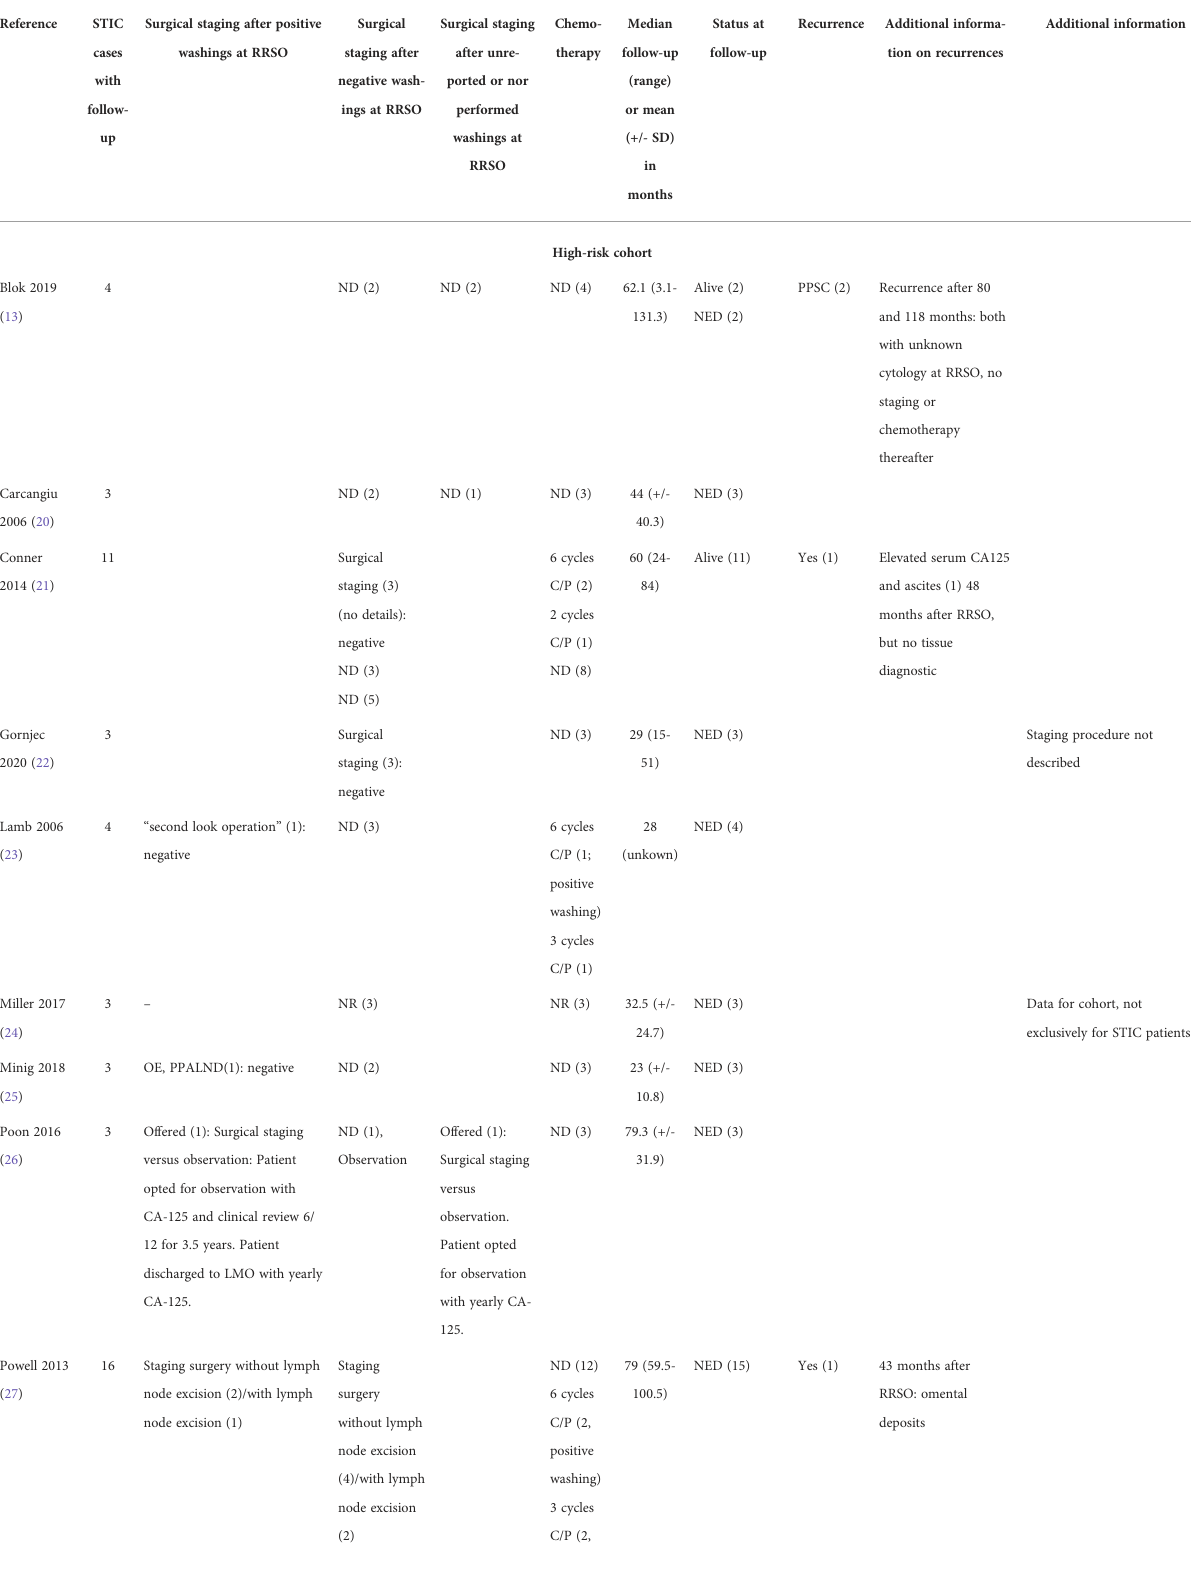
TABLE 2 Follow-up of patients with STIC included in our systematic review in alphabetical order (white: high-risk cohort; grey: low-risk cohort). Reference STIC cases